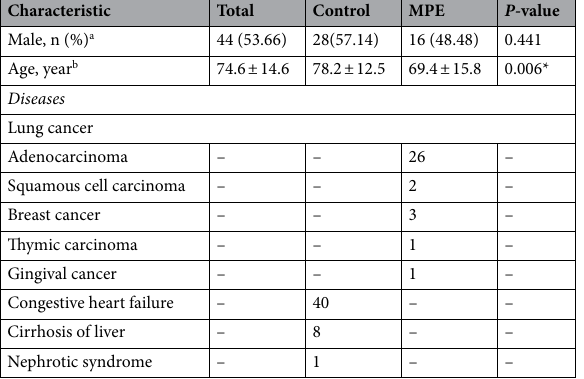
Table 1. Demographics and characteristics of the study group. a The chi-square test was used. b The two- independent sample T was used. * P -value <